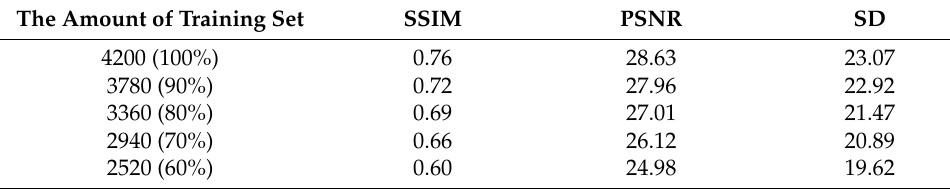
Table 10. Experimental results for minimum training data.